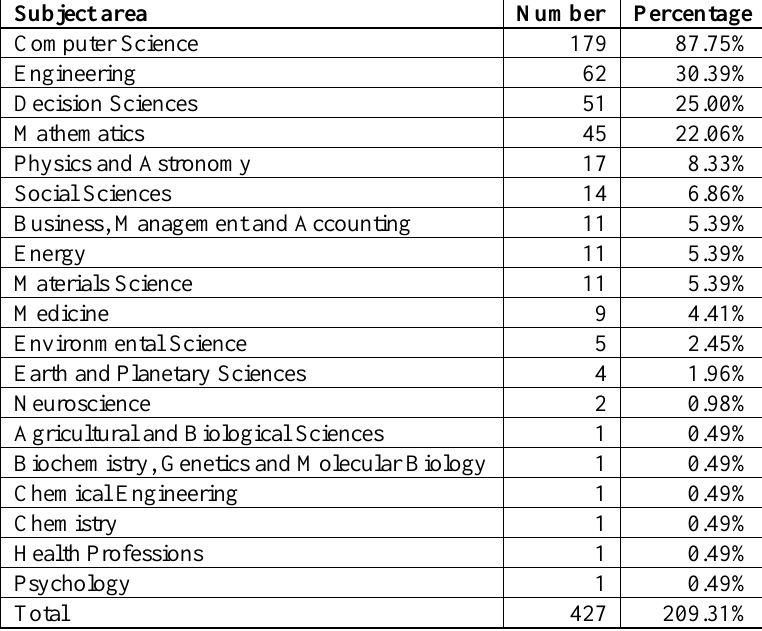
Table 6. Distribution of publications by subject